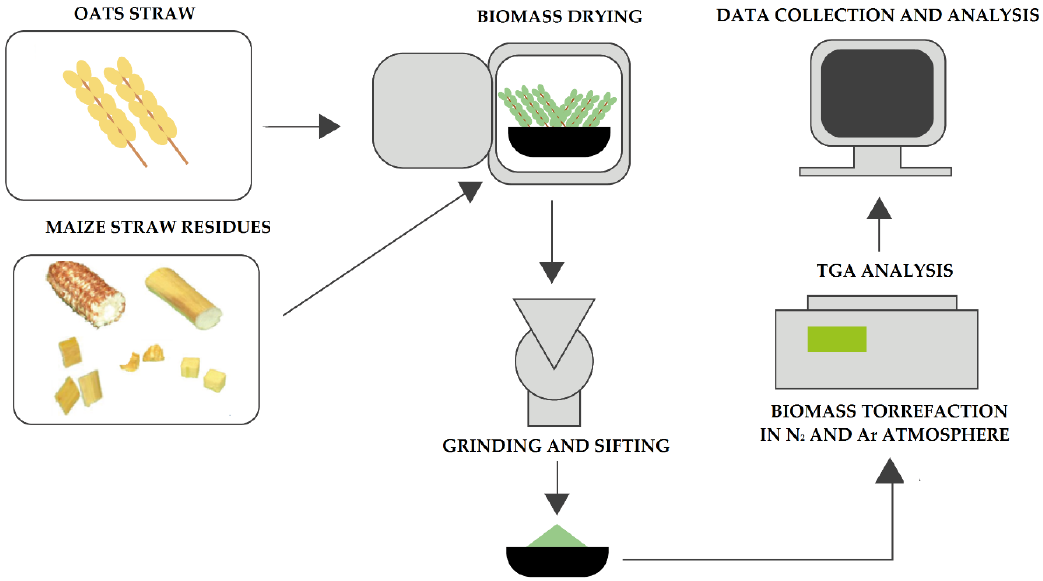
Figure 1. Principle of oats and maize straw torrefaction process with process conditions temperature and optimal mass loss using superheated steam for production of biofuel, activated carbon, and additive for natural fertilizers.